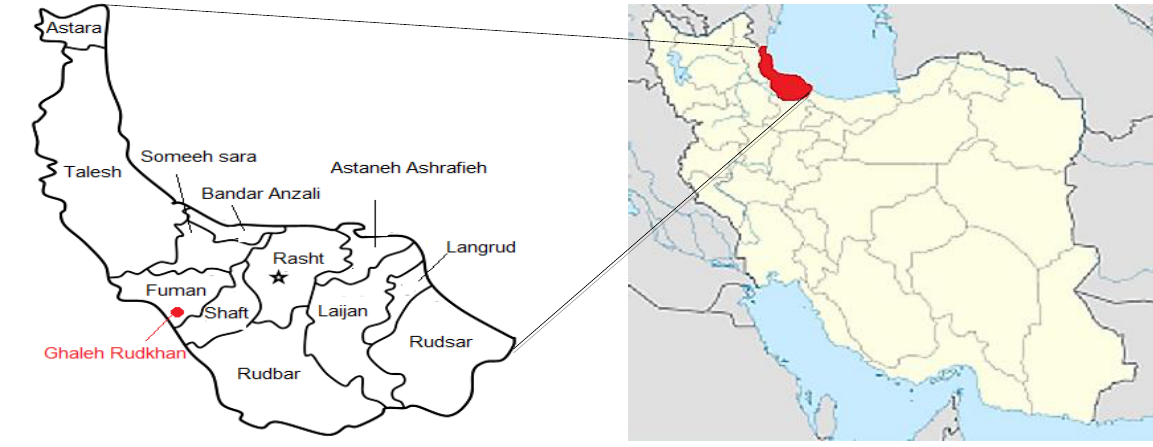
Fig. 1. Ghaleh Rudkhan forest